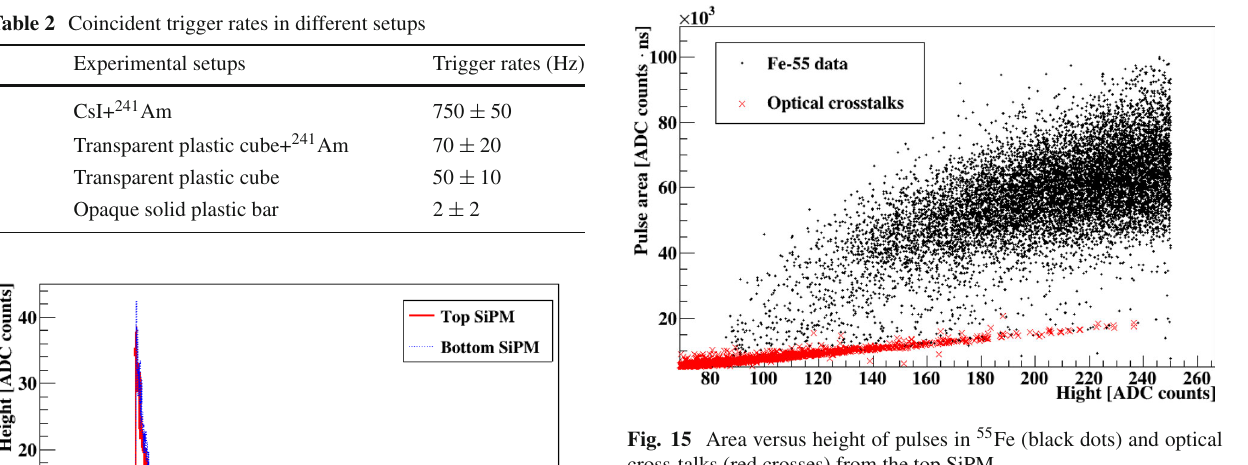
physical ones are needed to justify the proposed